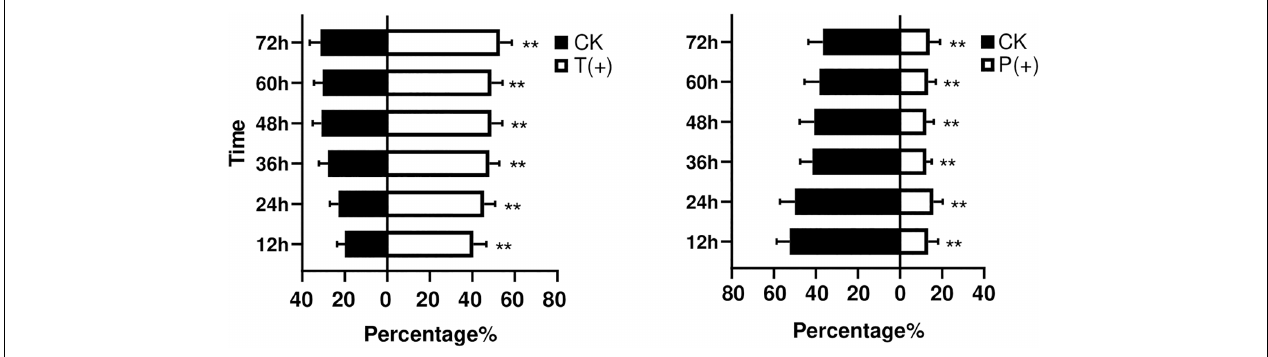
FIGURE 1 | Mean percentages ( ± SE) of B. tabaci adults selection over different observation times. ( ∗∗ Independent t -tests: P < 0.01).